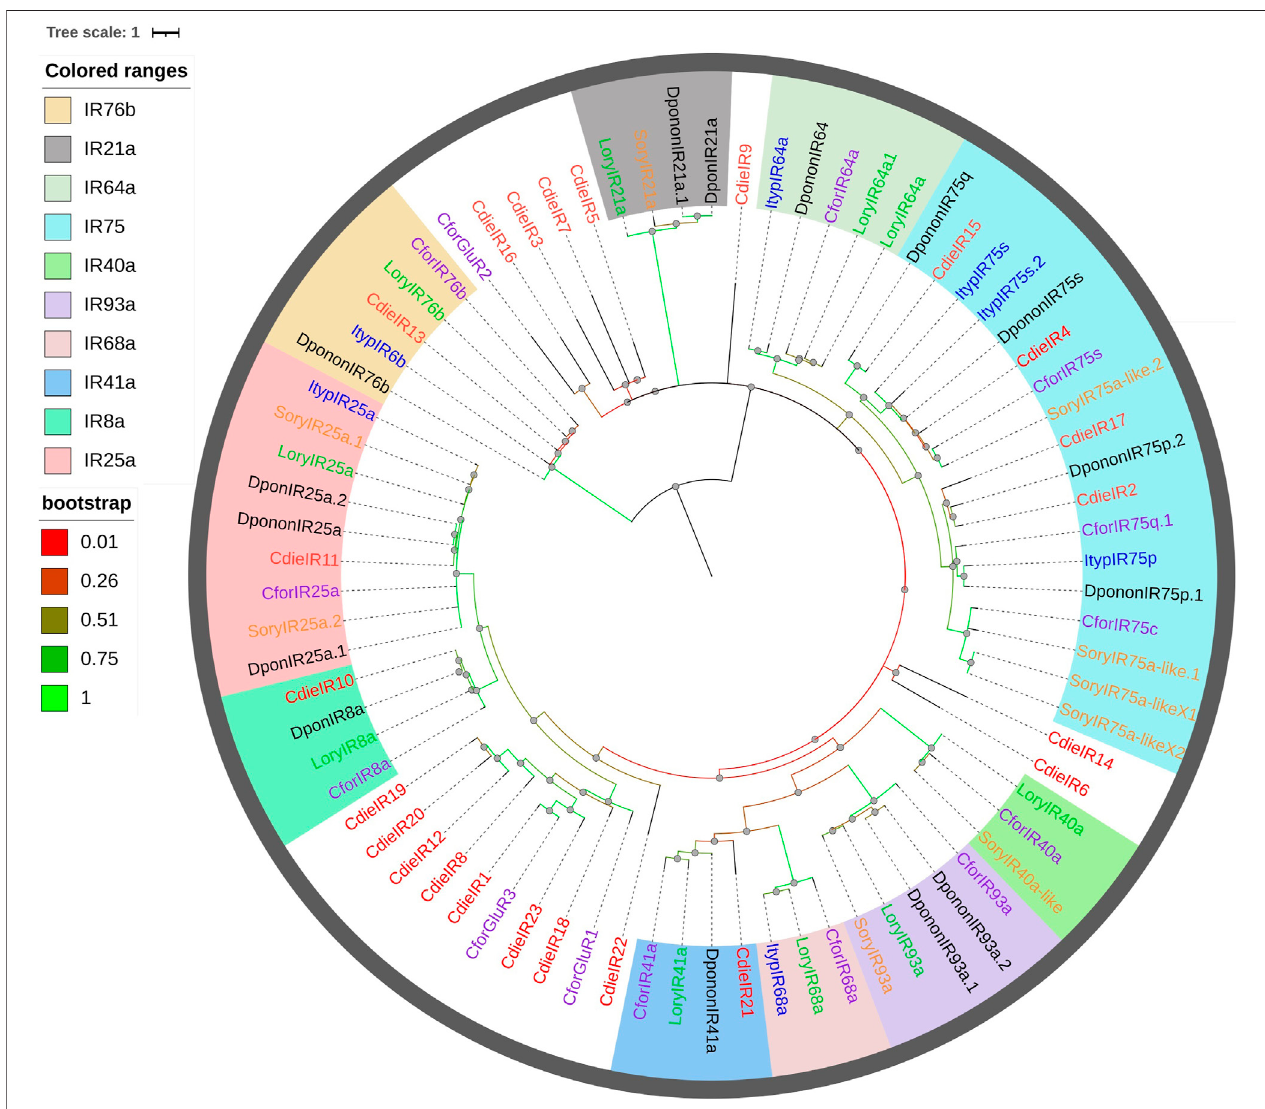
FIGURE 7 | Maximum likelihood phylogenetic tree of candidate IRs in C. dieckmanni (Cdie, red), Dendroctonus ponderosae (Dpon, black), Ips typographus (Ityp, blue), Lissorhoptrus oryzophilus (Lory, green), Sitophilus oryzae (Sory, orange), and Cylas formicarius (Cfor, purple). The scale bar represents 1 amino acid substitution per